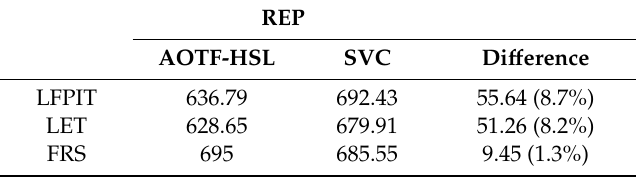
Table 6. The three di ff erent methods’ “Red edge” position results for dracaena yellow leaf.